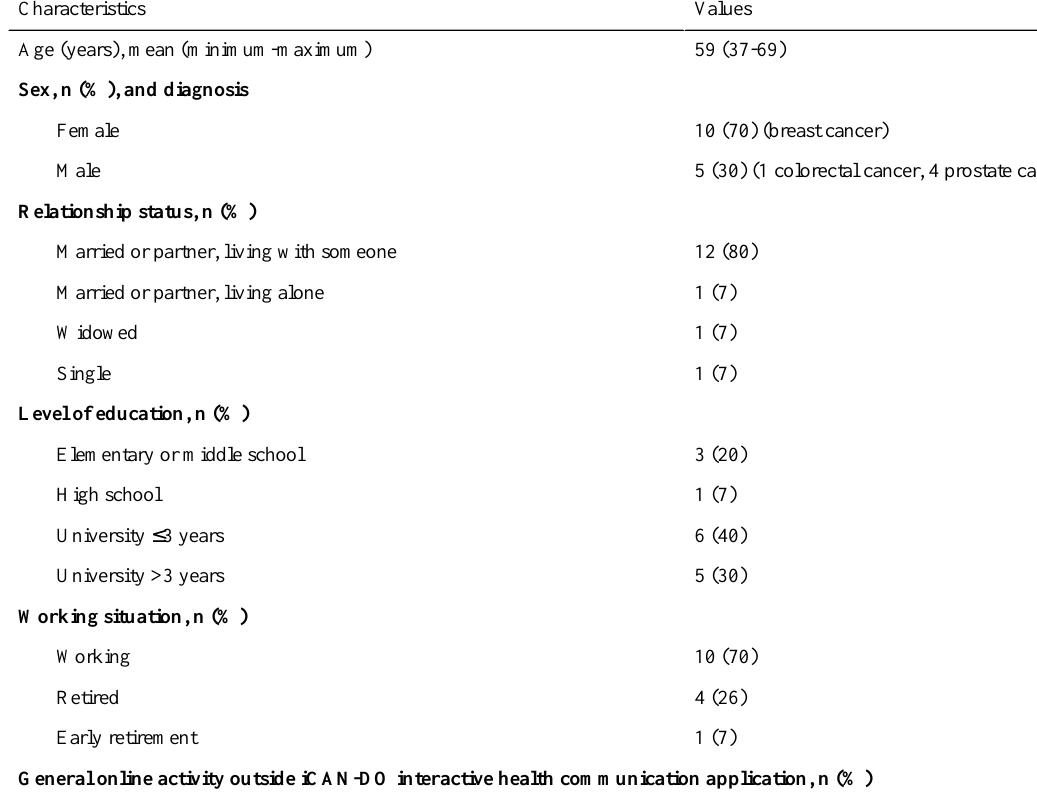
Table 2. Informants’characteristics (at time of diagnosis) (N=15).